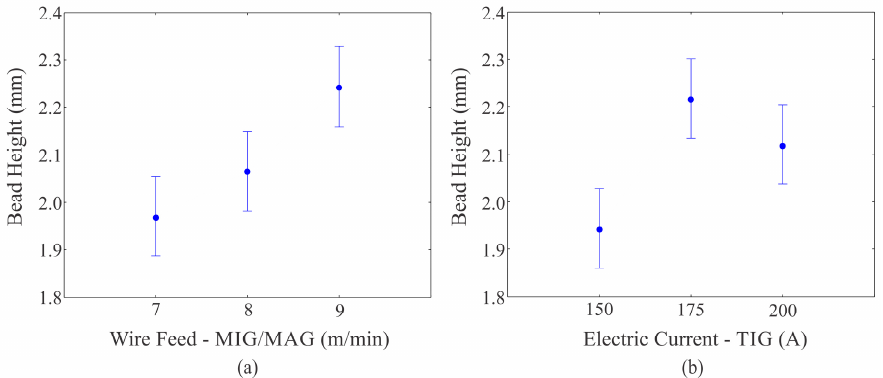
Figure 12. Effect of the welding factors on the bead height of the weld bead.